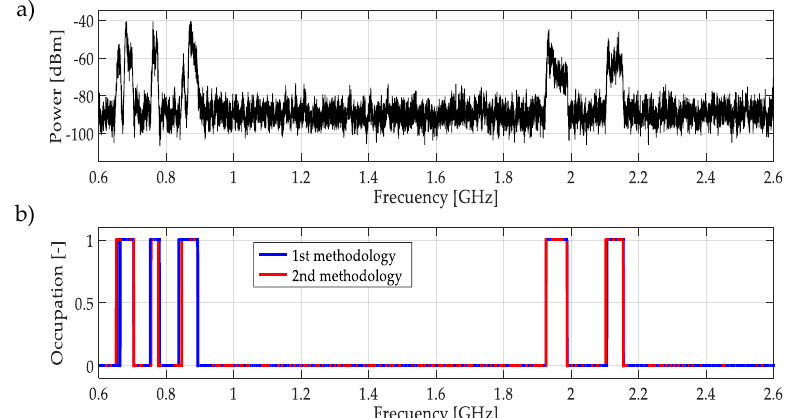
Figure 27. ( a ) A real signal obtained from the entire wideband of [0.6–2.6] GHz. ( b ) The result of applying both methodologies to the real signal in terms of spectrum occupancy. In this case, both methodologies have the same good performance.